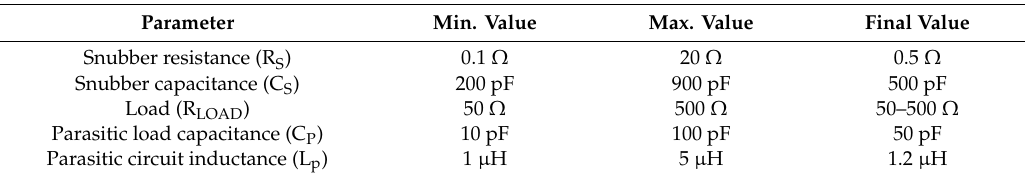
Table 2. Pulse forming circuit